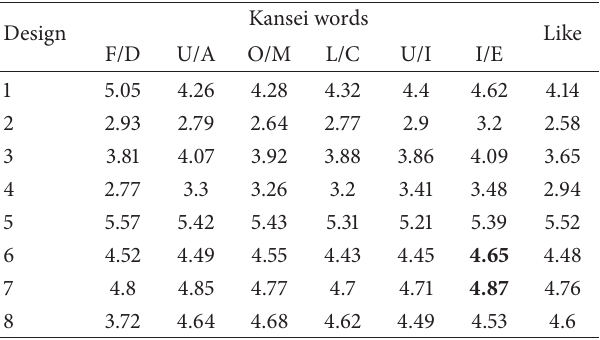
Table 3: The dominant of Kansei words towards the 8 design pro- posed using AHP. Design